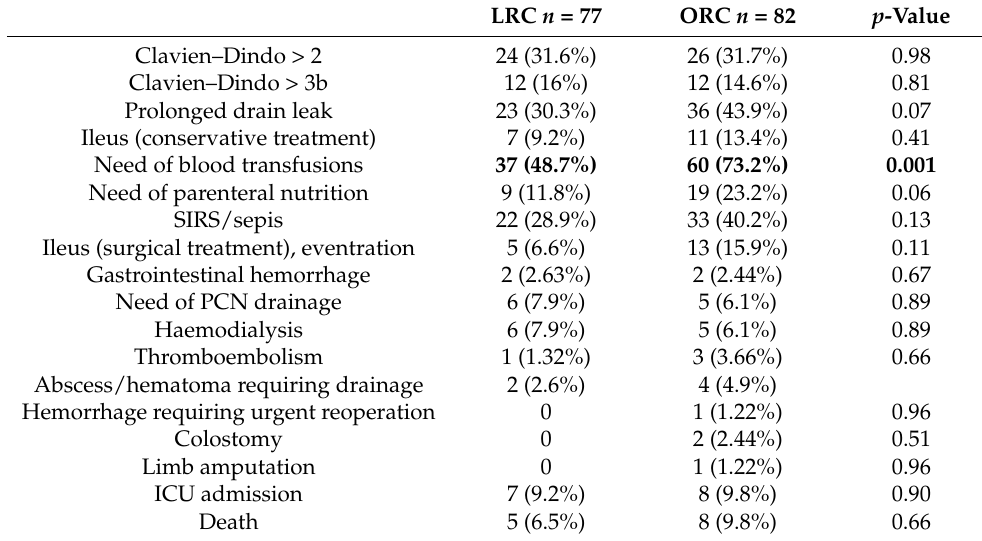
Table 3. Comparison of individual complications between LRC vs.